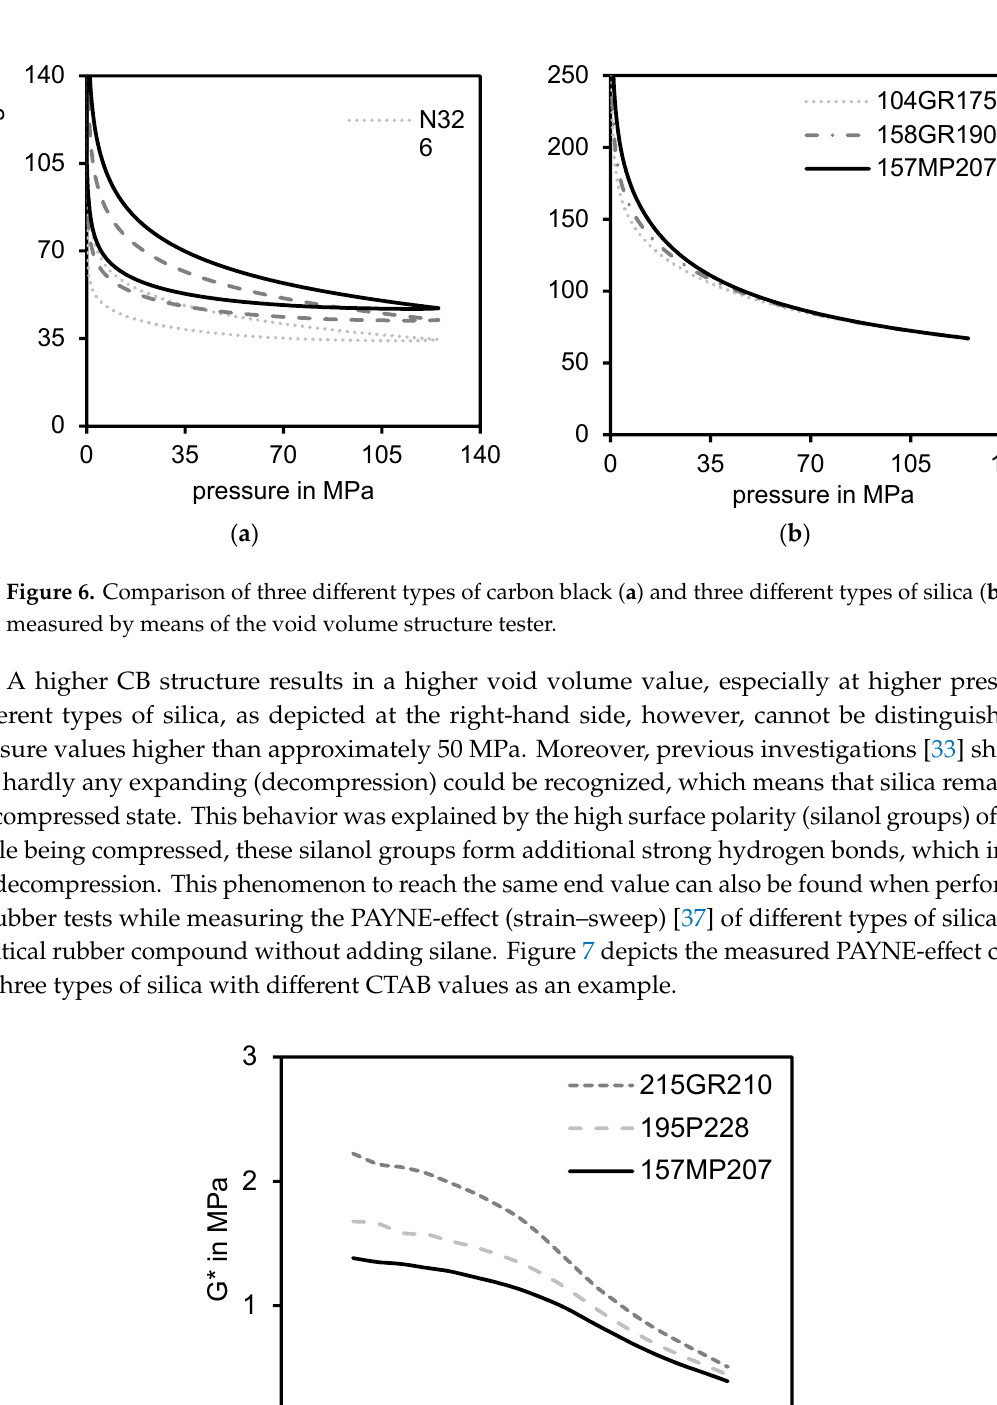
Table 4. Used carbon black types and their analytical parameters .